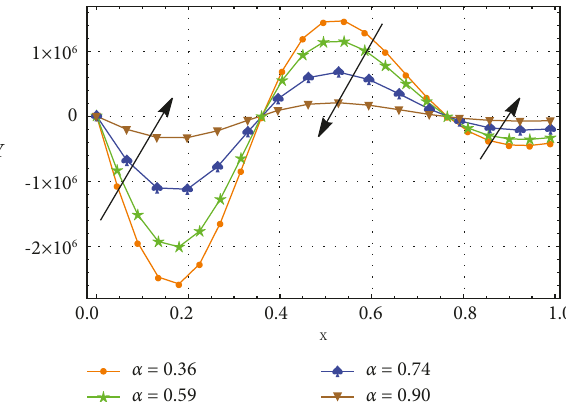
Figure 6: Effect of fractional parameter α on the wave profile in Example 2 when ρ � 1 and τ � 3.